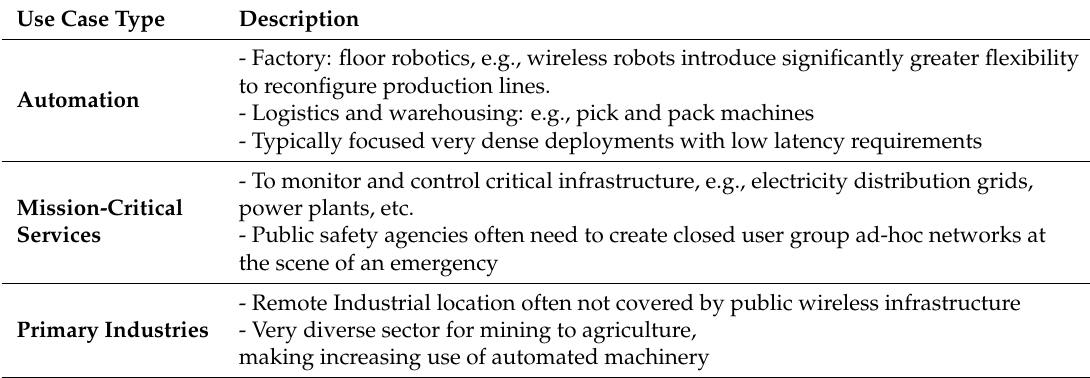
Table 1. Use case of 5G NR for Industry 4.0